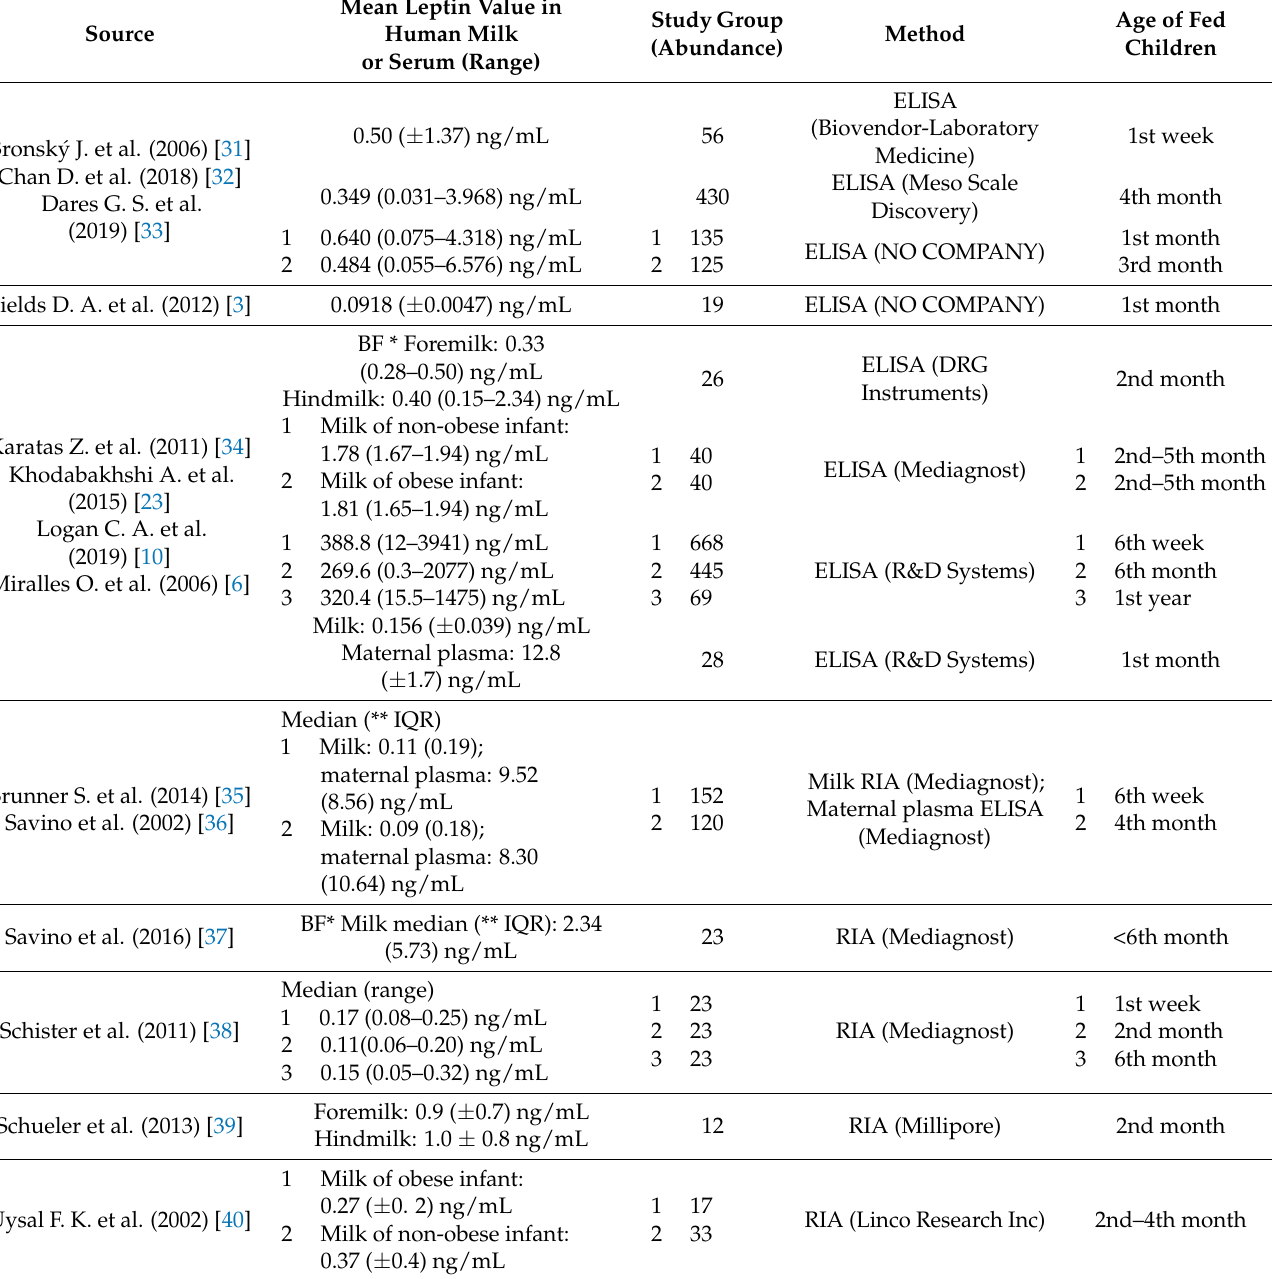
Table 1. Variability of the concentration of leptin in human